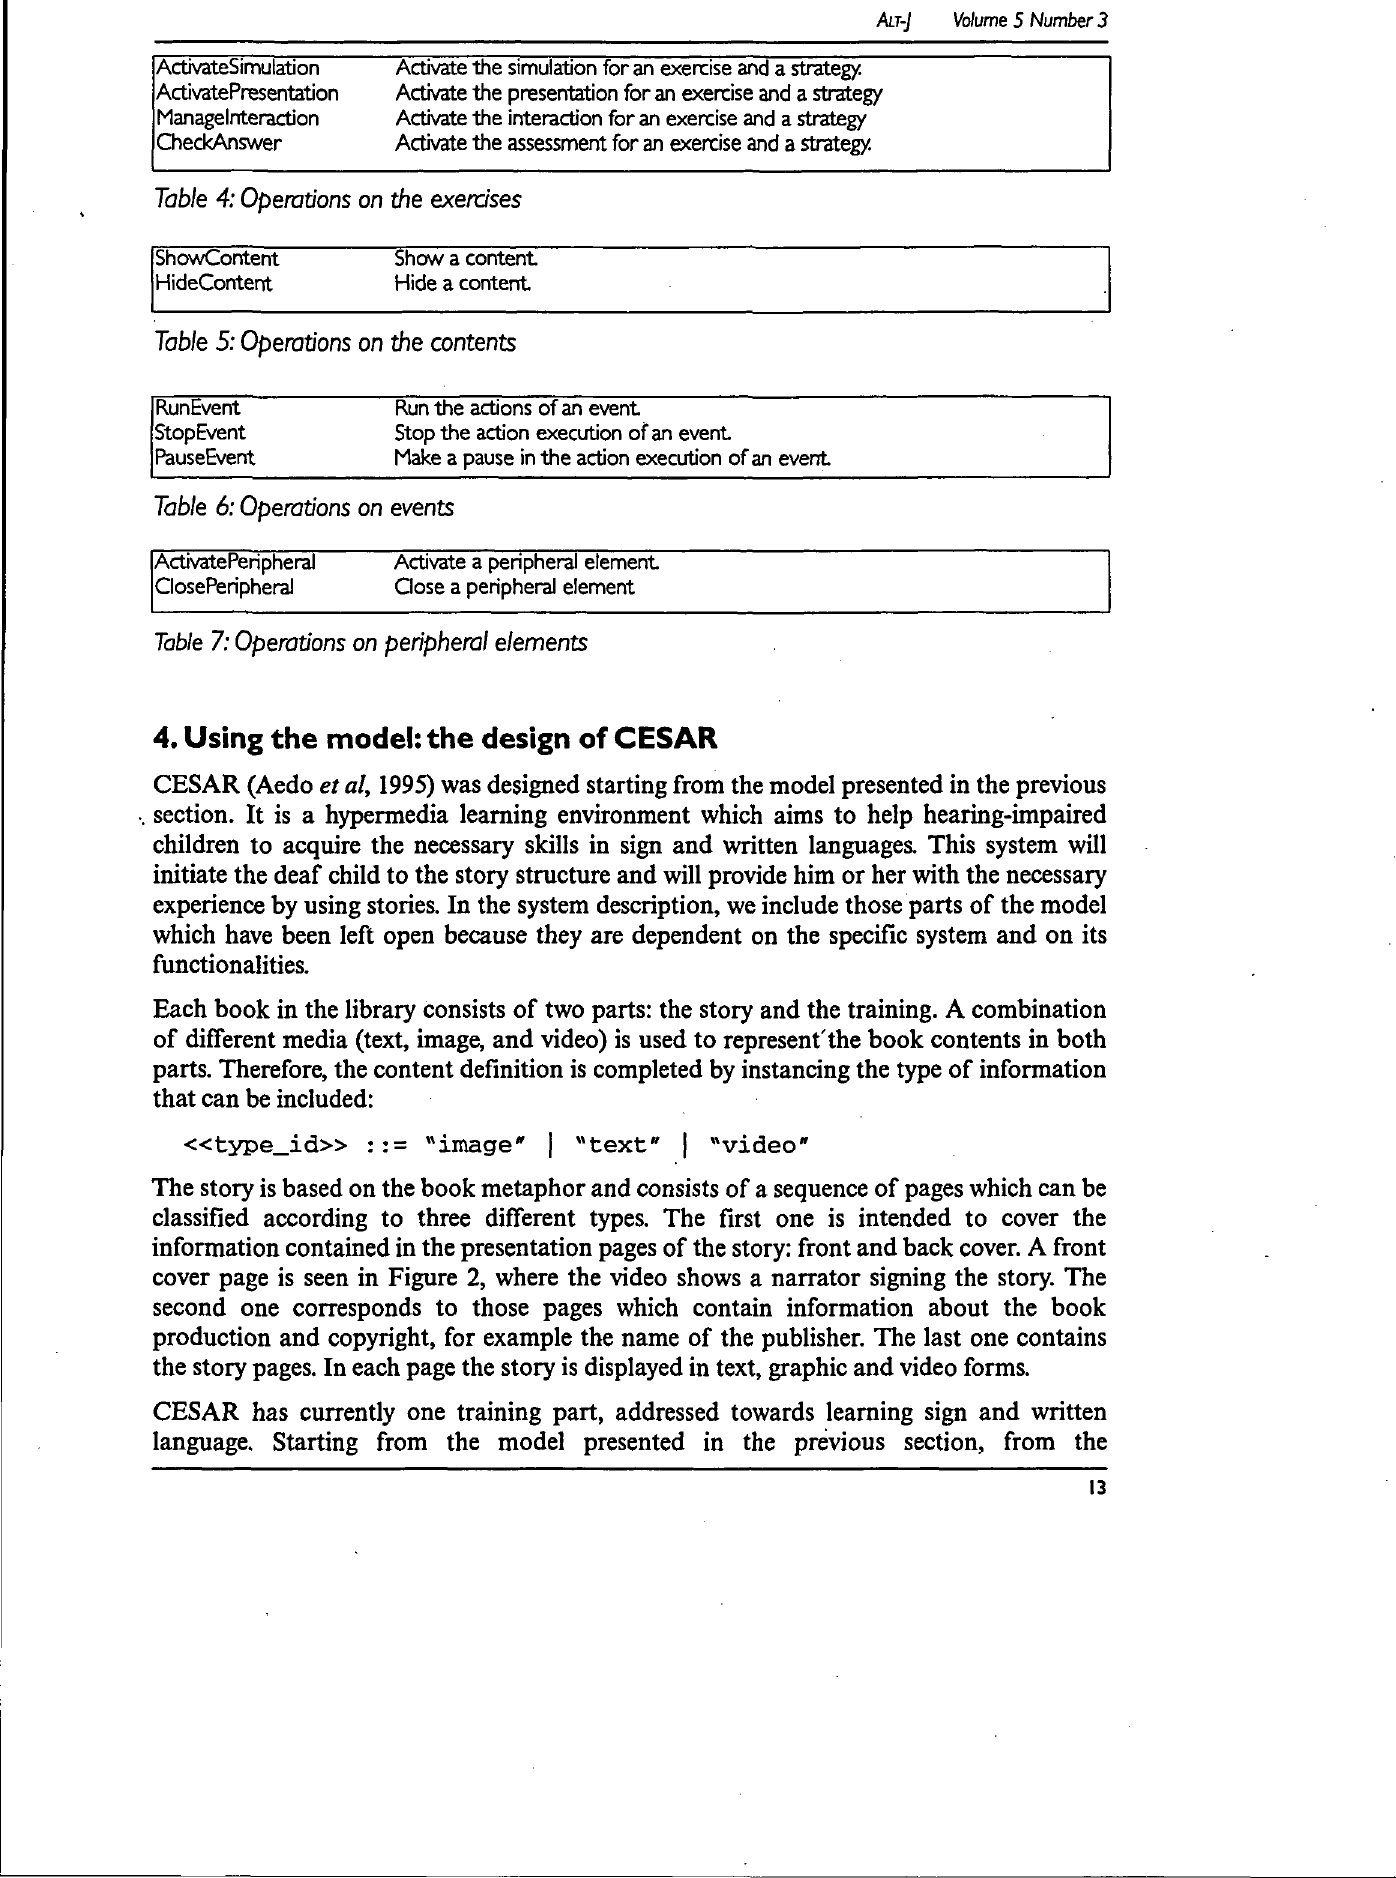
Table 5: Operations on